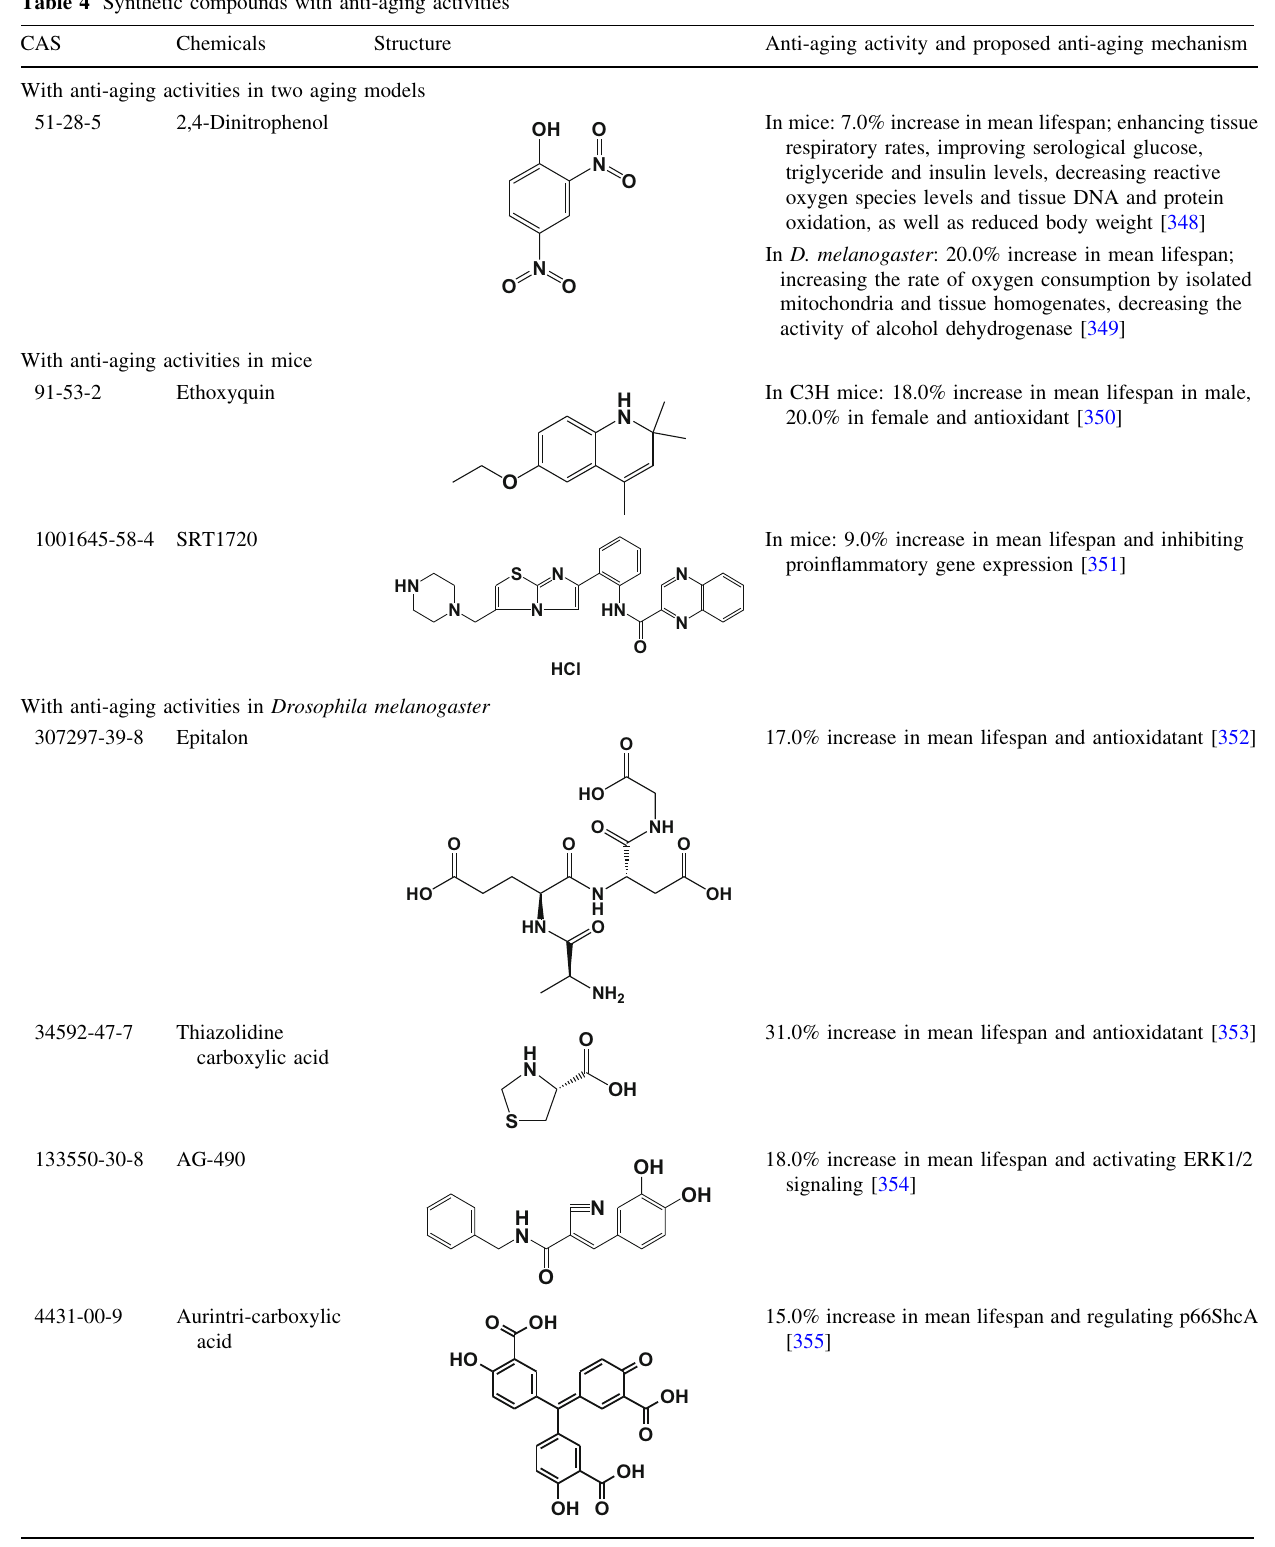
Table 4 Synthetic compounds with anti-aging